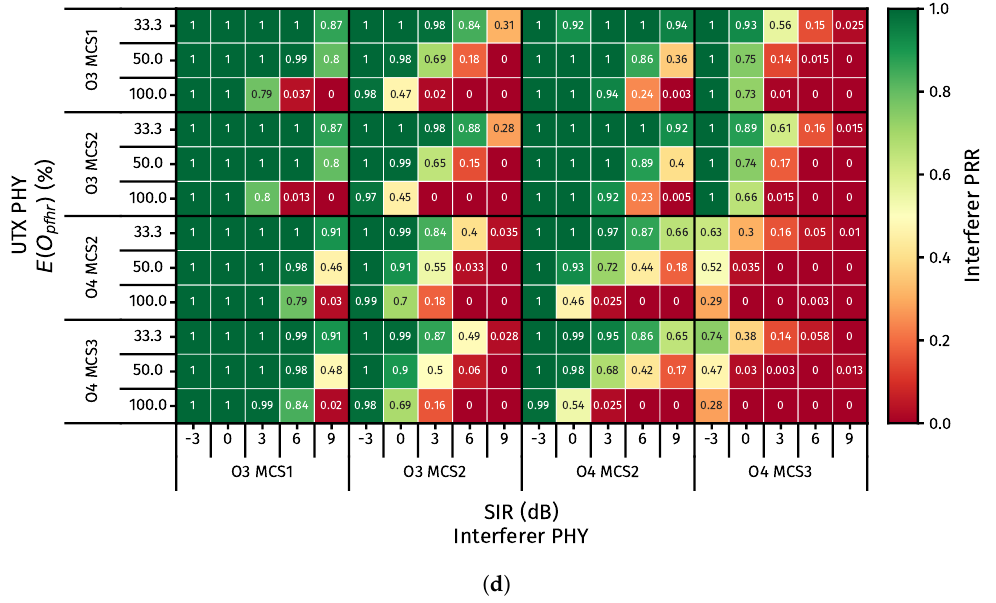
Figure 7. Results of targeted interference experiments in anticipation of deterministic intra-network interference. Each sub-figure depicts the Packet Reception Rate (PRR) ∈ [ 0,1 ] (with one being 100% successful reception) of a given transmission in a given overlap scenario. The primary x and y axis respectively show the interferer and useful transmitter (UTX) PHY configuration so that each black rectangle contains the PRR for every Signal to Interference Ratio (SIR) (secondary x axis) and overlap (secondary y axis) combination for the corresponding PHY combination. Since an enhanced acknowledgement (Enh-Ack) is of fixed size, O pp differs between PHY combinations. Hence, non applicable O pp is left white. ( a ) UTX PRR with overlap in PHY payload. ( b ) Interferer PRR with overlap in PHY payload. ( c ) UTX PRR with overlap in PFHR. ( d ) Interferer PRR with overlap in